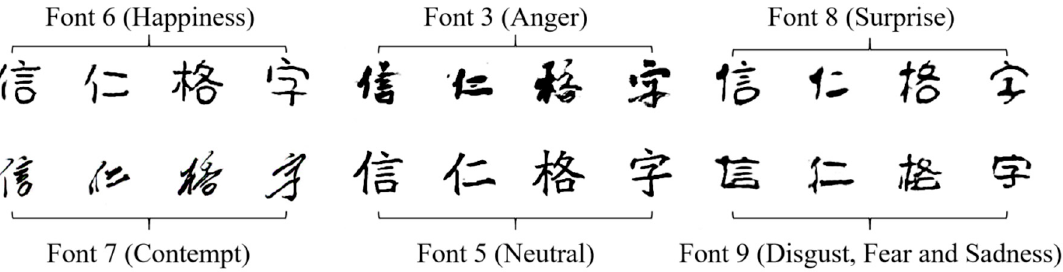
Figure 12. Fonts generated by our proposed model for reliability analysis.